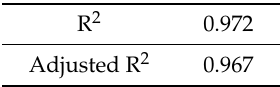
(Number of load cycles) - Log 10